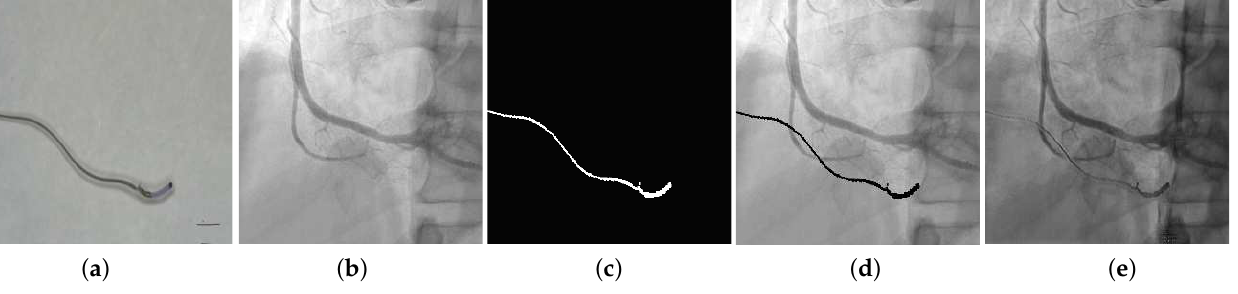
Figure 4. ( a ) Catheter in natural image ( b ) X-ray image without catheter ( c ) camera catheter mask generated using [45] given ( a ) as input ( d ) composited X-ray with camera catheter mask ( e ) generated X-ray image using camera